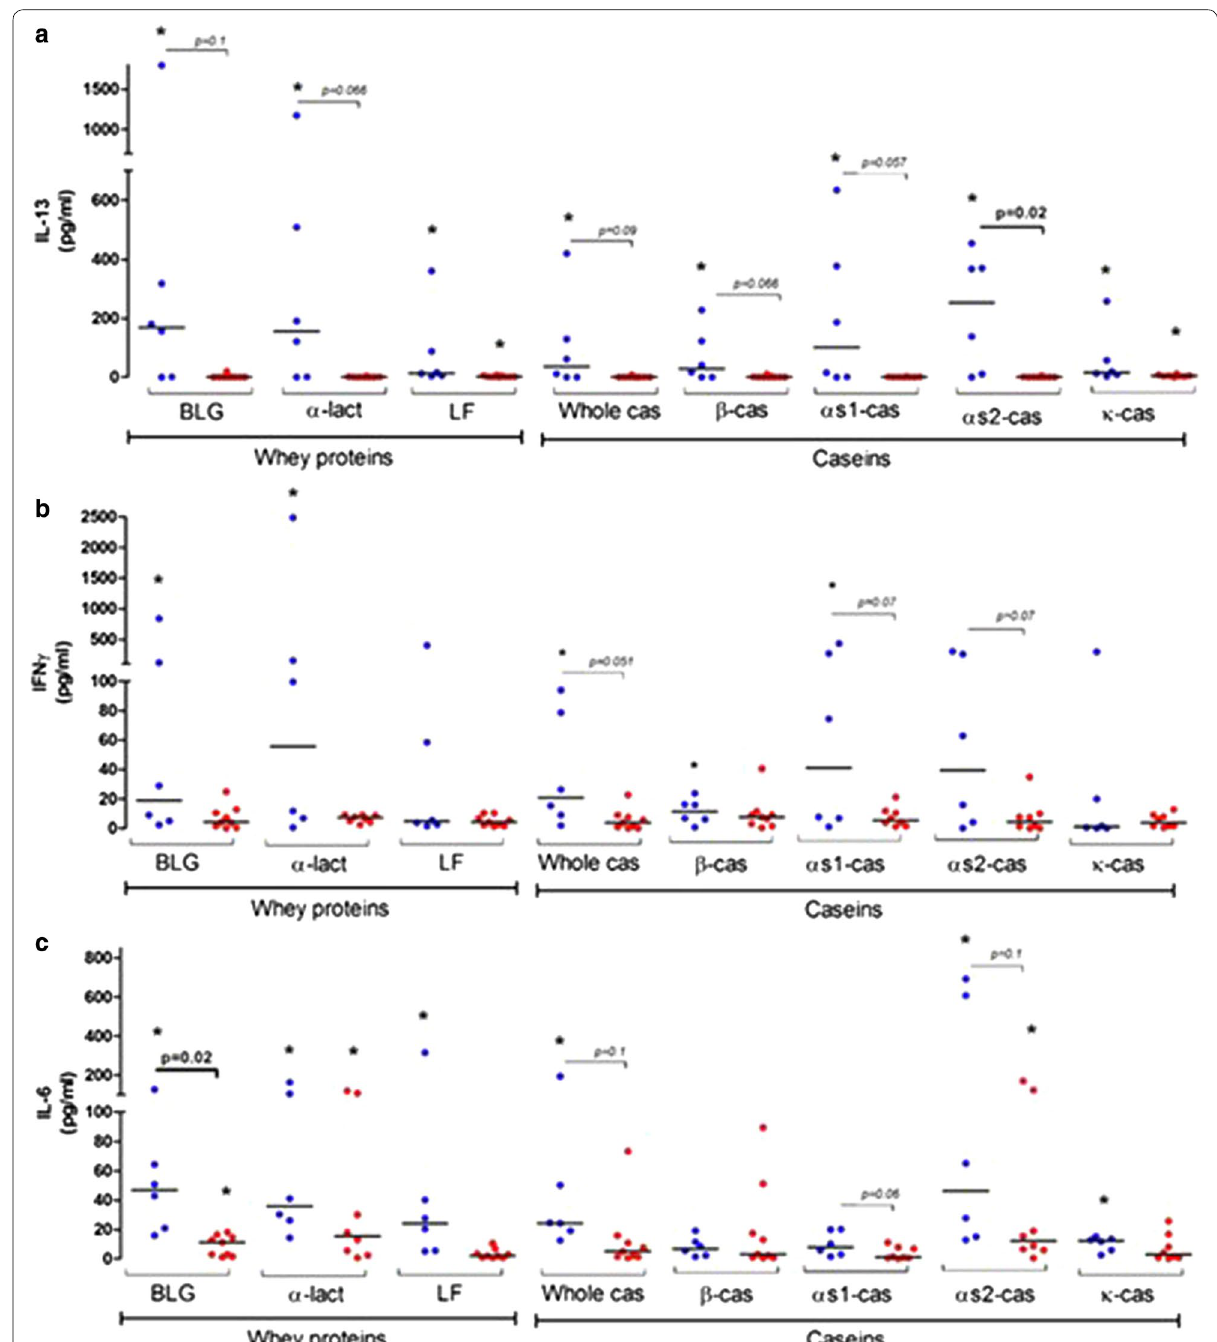
Fig. 5 IL‑13 ( a ), IFN γ ( b ) and IL‑6 ( c ) secreted after specific reactivation of PBMC from IgE‑CMA (blue) or FPIES‑CMA (red) patients. PBMC were stimulated for 6 days with 50 µg/mL of purified allergens and cytokines were assayed in supernatants. Results are expressed as individual values and medians (bar) obtained for the PBMC from IgE‑CMA (n 6) or FPIES‑CMA (n 9) patients. * indicates a difference between control (PBS and/or Ara = = h 2) and stimulated PBMC in the same group of patients ( p < 0.05 using Wilcoxon sign rank test); Significant difference or trends between IgE‑CMA and FPIES‑CMA patients are also mentioned with the associated p value (Mann–Whitney t